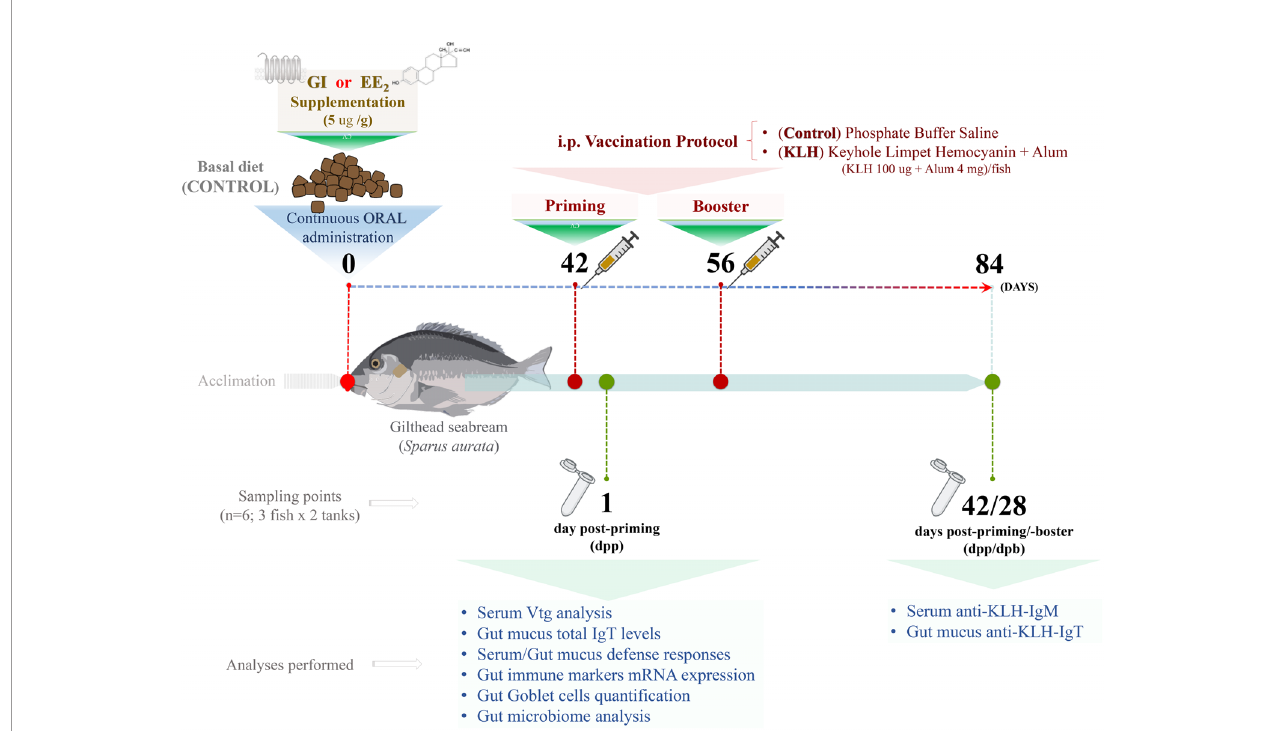
FIGURE 1 | Experimental setup. From day 0, control or supplemented diet with G1 or EE2, orally administered daily within 84 days (12 weeks) to gilthead seabream. After 6 weeks, on day 42, half of the animals from each group were immune primed and boosted 15 days later (8 weeks) by intraperitoneal injections (i.p.) with repeated doses of the model vaccine containing KLH as antigen. The analyses in the list were conducted at 1 and 42 days after receiving the priming immunization (6 and 12 weeks, respectively). N=6; three fi sh from each duplicated tank per